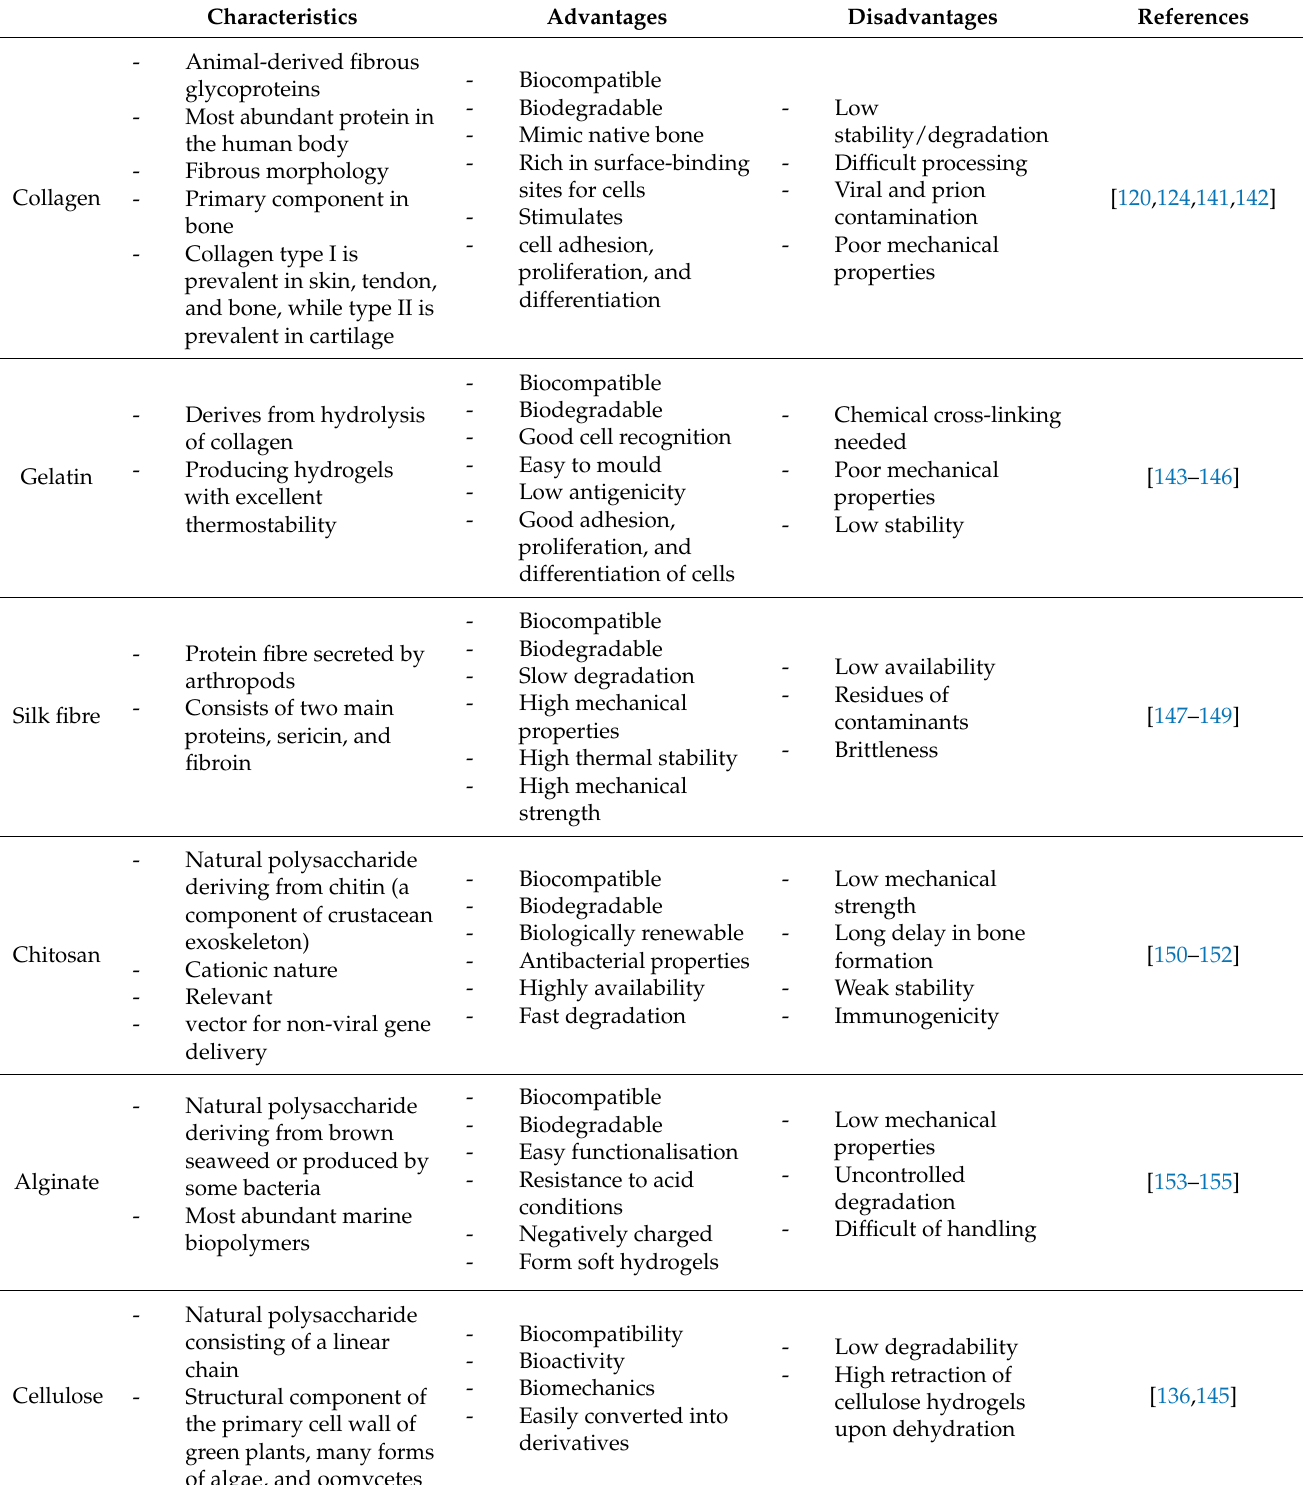
Table 6. Characteristics of most useful natural polymers (protein- or polysaccharide based) used to fabricate 3D hybrid scaf-